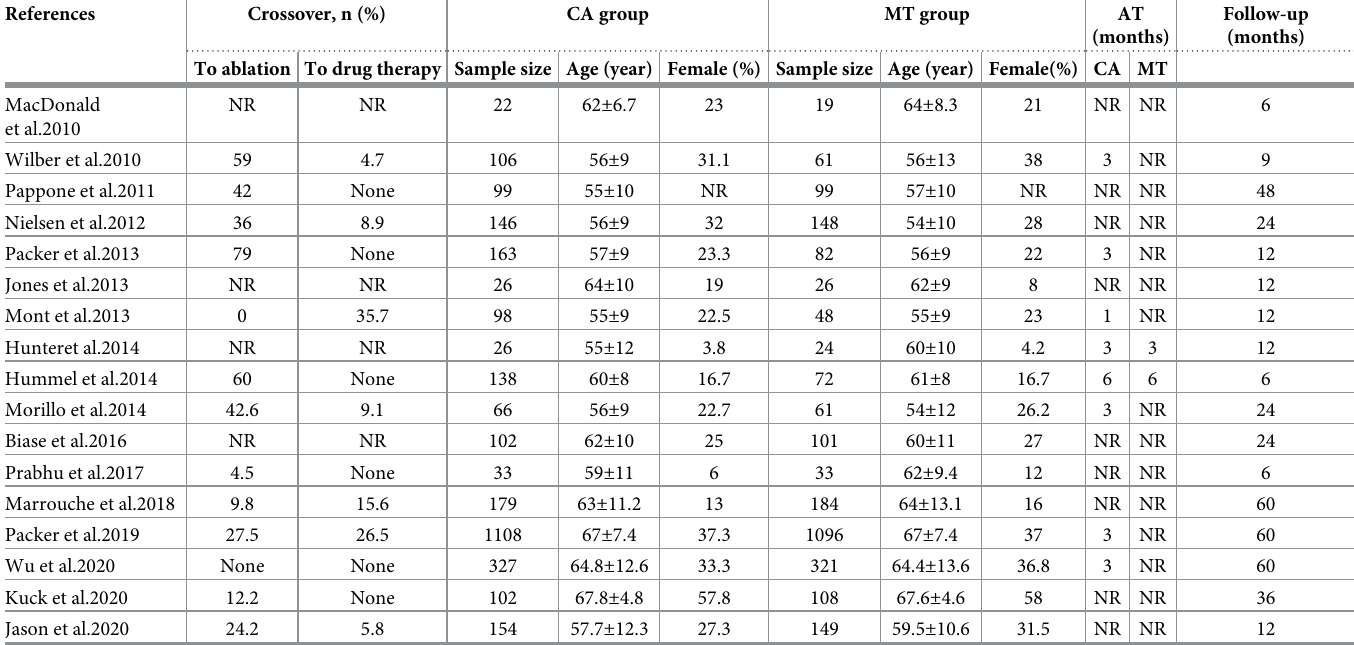
Table 1. Study characteristics of the randomized trials included in the meta-analysis.